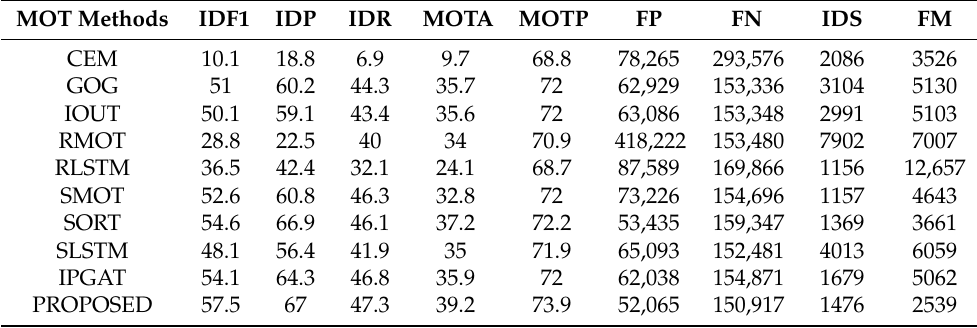
Table 4. RON evaluation with respect to performance metrics. MOT: multiple object tracking; IDP: identification precision;